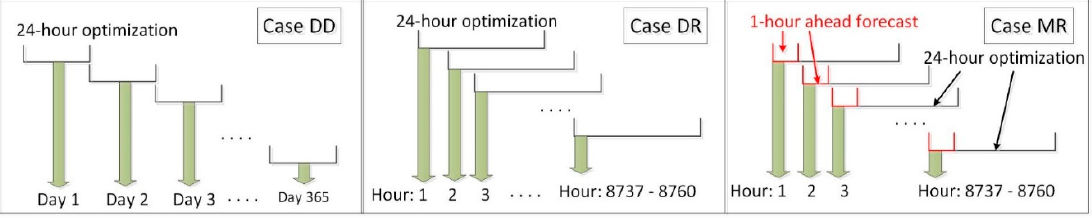
Figure 3. The diagrams of Cases DD, DR and MR.